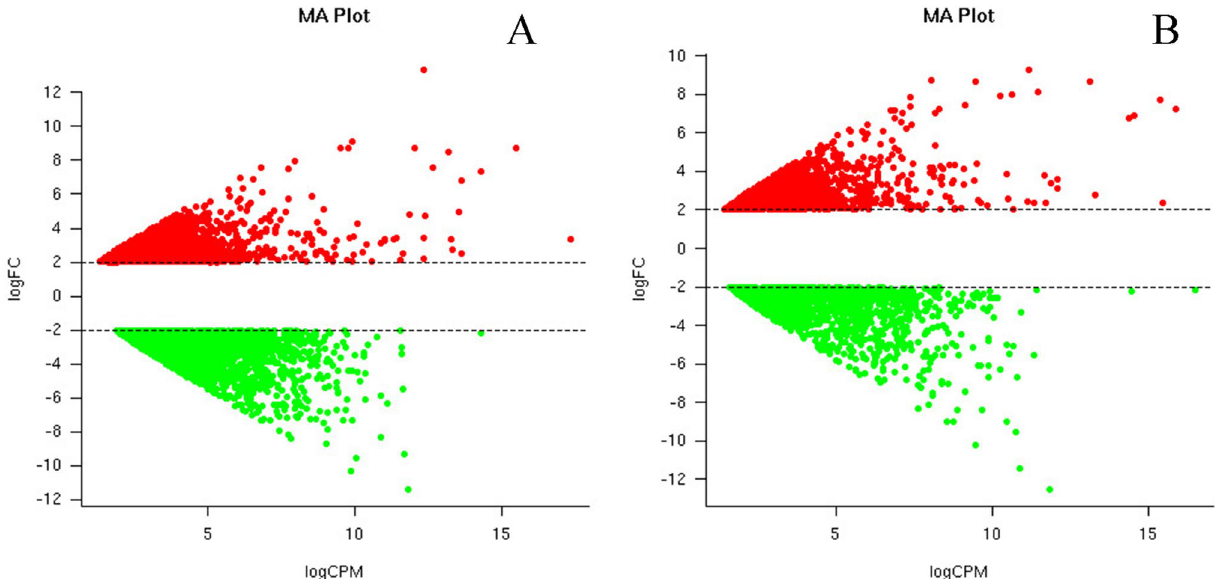
Figure 9. MA plot representing differential expression genes in terms of up-regulated and down-regulated ( A ) isoforms and ( B ) unigenes. The values are represented as the function of logFC vs. logCPM at p value of < 0.05 and FDR rate of <